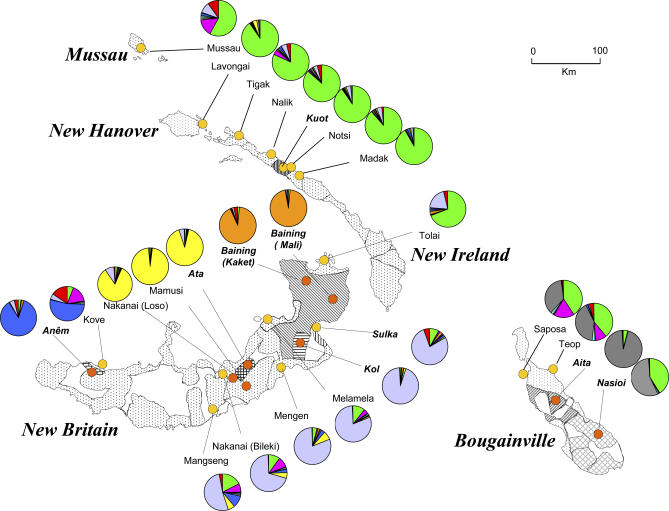
The Geographic Patterning of STRUCTURE ResultsDistribution of cluster assignment percentages (in pie-charts) among Northern Island Melanesian populations for K=10. Oceanic-speaking regions are stippled; the different Papuan-speaking regions have stripes or grid marks. Papuan-speaking group names are in bold italics. Inland group locations are dark orange dots; shore group locations are light orange dots. Baining (Mali) and Baining (Kaket) are two dialects; elsewhere, the two Kaket-speaking locales are identified (Rangulit and Malasait), as is Marabu (Mali-speakers).